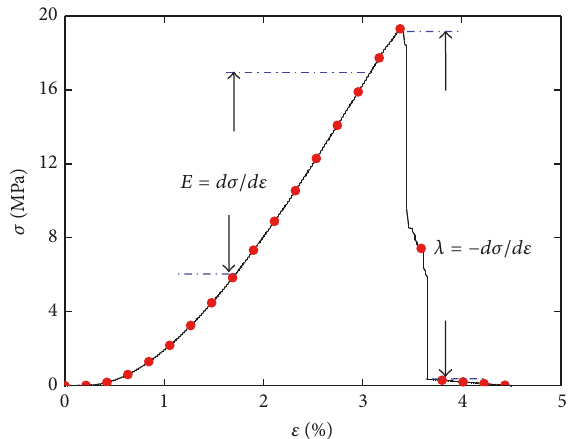
Figure 6: Complete stress-strain curve of a uniaxially compressed coal